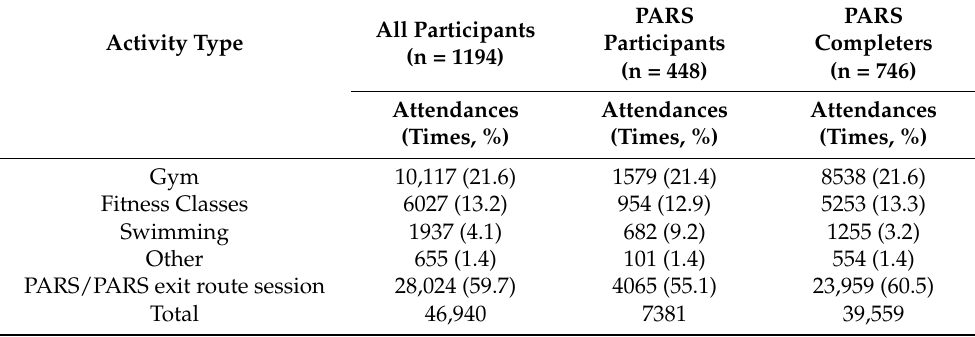
Table 2. Attendance and activity